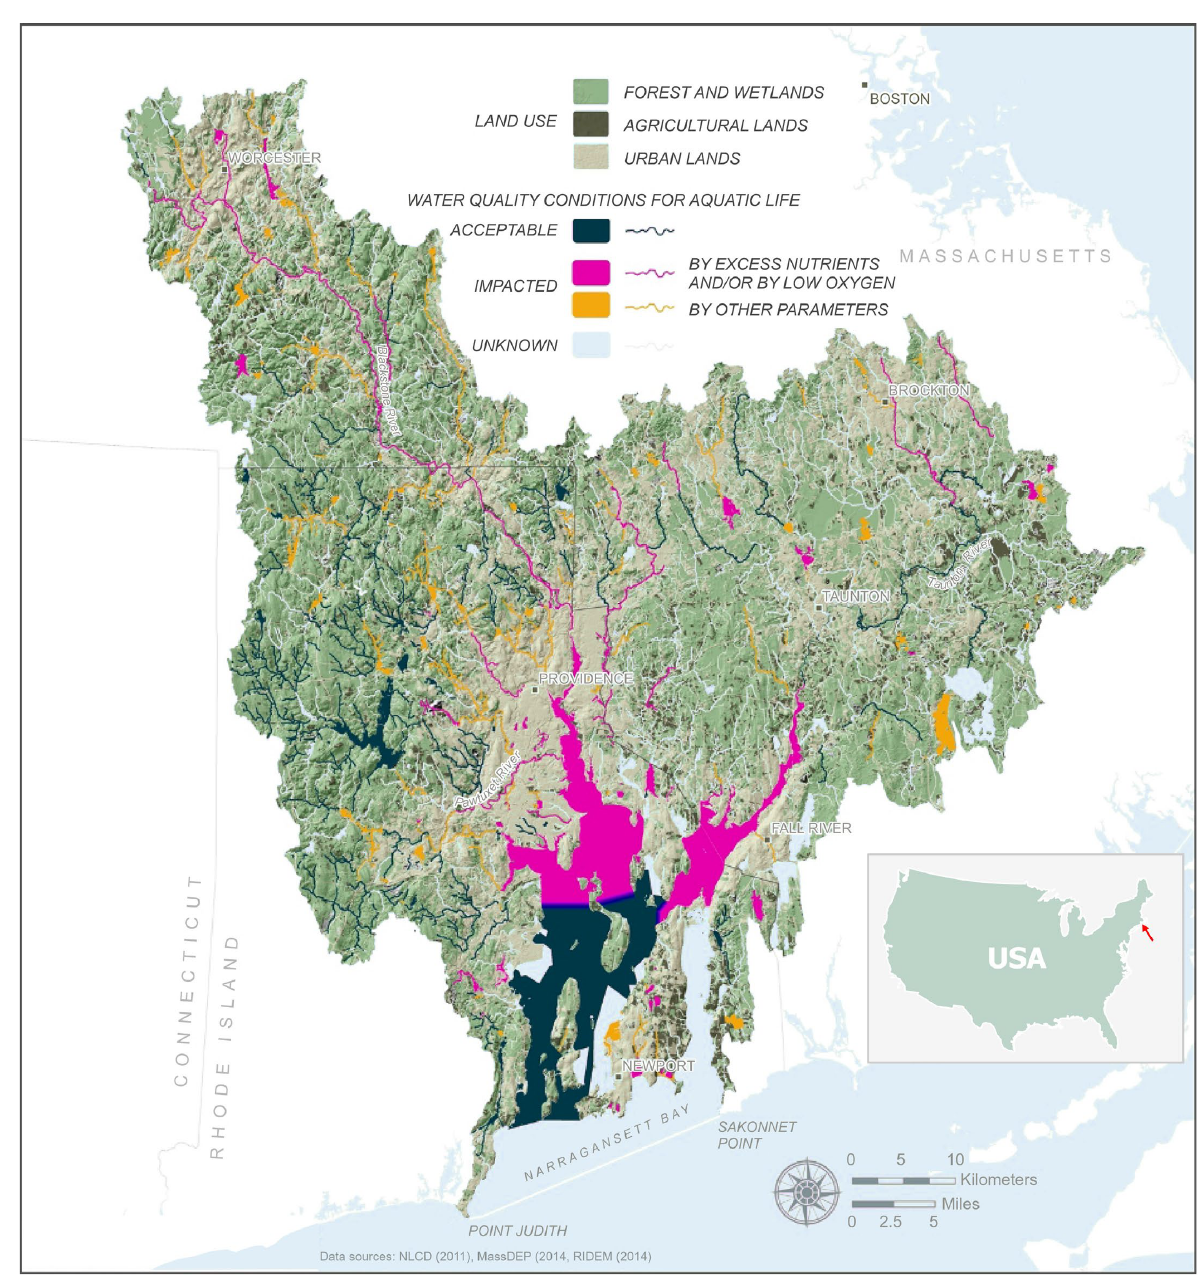
Figure 1. Site location of Narragansett Bay featuring details of land - use ( forest and wetlands, agricultural, and urban ) and locations of acceptable and impacted water quality (Adapted with permission from [17] ).